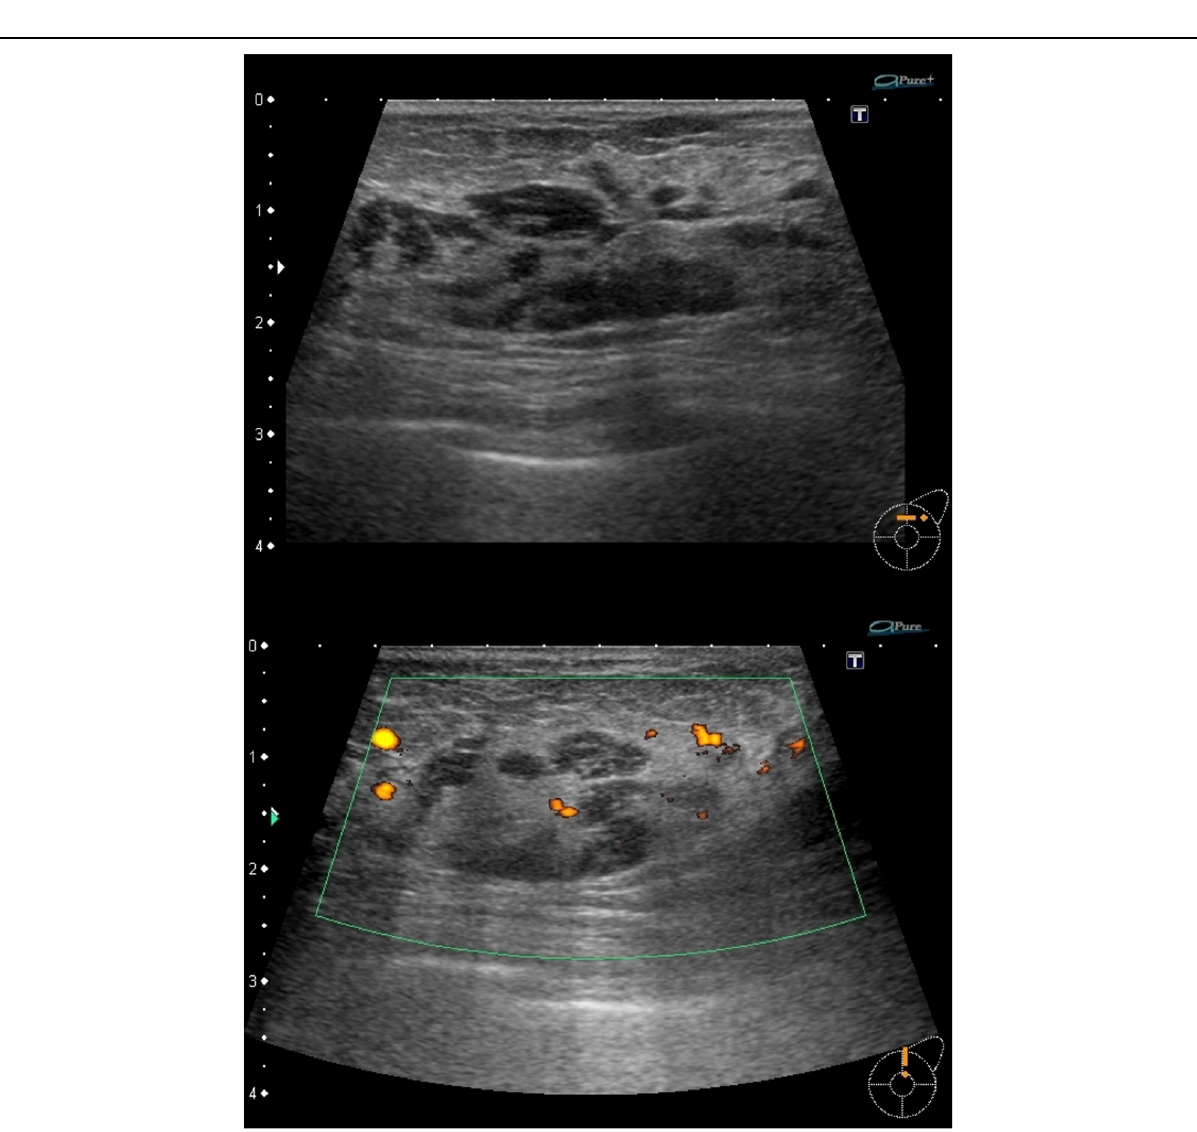
Fig. 2 Ultrasonography of the left breast. The C region of the left breast contained an irregularly shaped, poorly echoic region. Large- and small- sized irregularities were observed over a wide range that excluded the B region. The mammary gland tissues clearly differed in both properties and thickness between the left and right sides. A poor blood flow signal was observed on Doppler ultrasonography. Swelling and thickness were observed in several axillary lymph nodes; however, the cortical echo level was low and internal heterogeneity was observed mostly using the lymph node gate; this finding was not